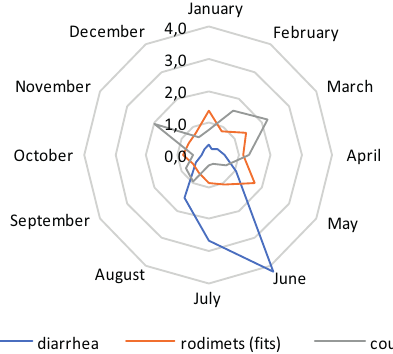
Figure 6. Seasonal indices of some causes of death (diarrhea, rodimets (siezures), cough) among infants, all social classes, both sexes. Source: the author’s calculations according to registers of the Pokrovsky parish